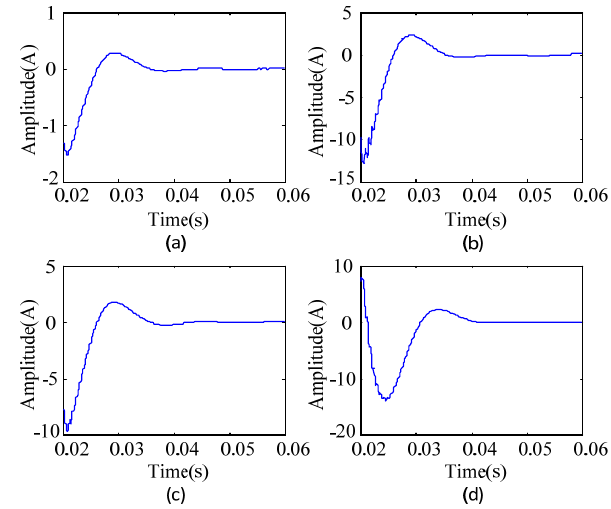
Figure 13. NPFCs after smoothing (Case 2). ( a ) Lian L 1 ; ( b ) Lian L 2 ; ( c ) Lian L 3 ; ( d ) Lian L 4 .